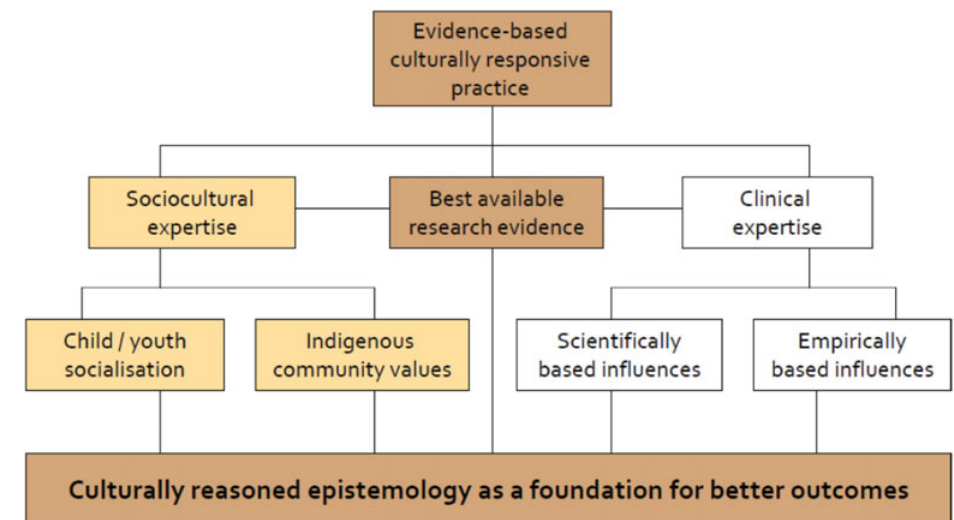
T¯o T¯atou Waka: A Blending of Clinical and Cultural Streams (Macfarlane et al., 2011).